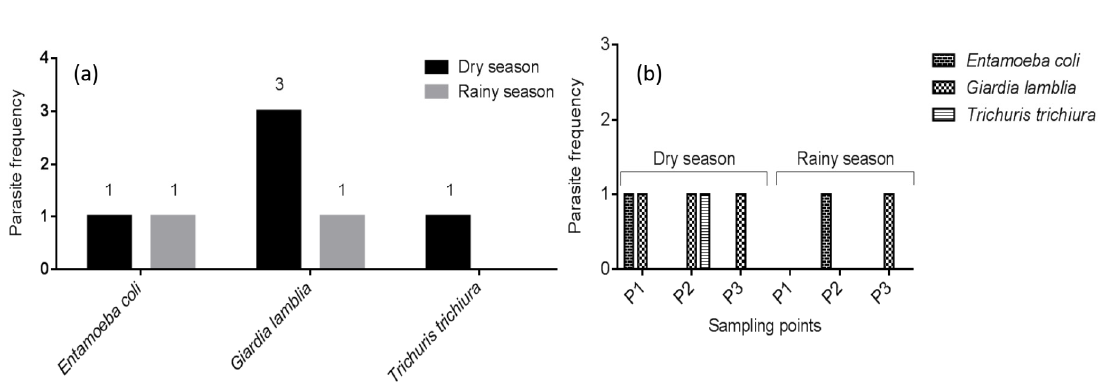
Figure 5. Parasitological analysis, ( a ) frequency in dry and rainy seasons, ( b ) for the three points analyzed in the rainy and dry season.